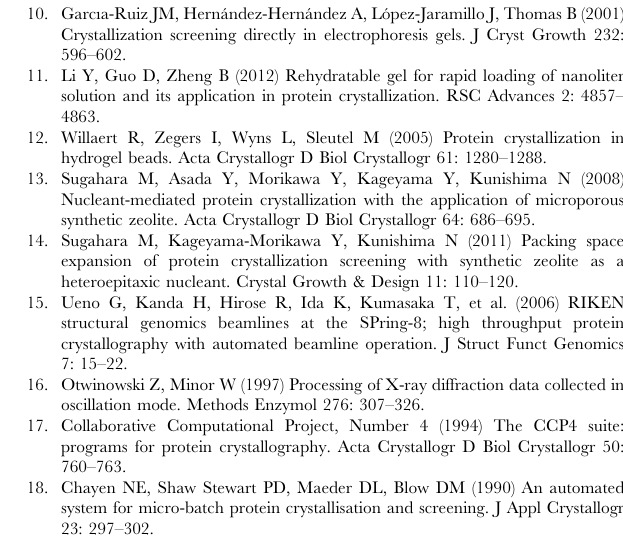
Figure S1 Photographs of the storage process of a gel bead on a syringe-needle probe in liquid nitrogen. (A) The syringe-needle probe is mounted on a goniometer head. (B) The CryoTong is placed over the probe. (C) The probe is removed from the goniometer head. (D) The Vial Clamp is used to hold the probe in a dewar containing liquid nitrogen. (E) The probe is positioned into the CrystalCap vial. (F) The CryoCane is stored in a liquid nitrogen storage dewar. (TIF) Figure S2 Photographs of protein crystals. Streptavidin from Streptomyces avidinii without MS (A) and with MS (B). Glucose isomerase from Streptomyces rubiginosus without MS (C) and with MS (D). ID70032 protein from Pyrococcus horikoshii OT3 without MS (E) and with MS (F). Crystallization of the three proteins was performed using the oil-microbatch method, as described previously [13]. (TIF) Figure S3 X-ray diffraction patterns of lysozyme crys- tals. Each crystal grown in gel bead (A) and on gel surface (B) was exposed to X-rays. (TIF) Table S1 Crystallization conditions for alginate gel